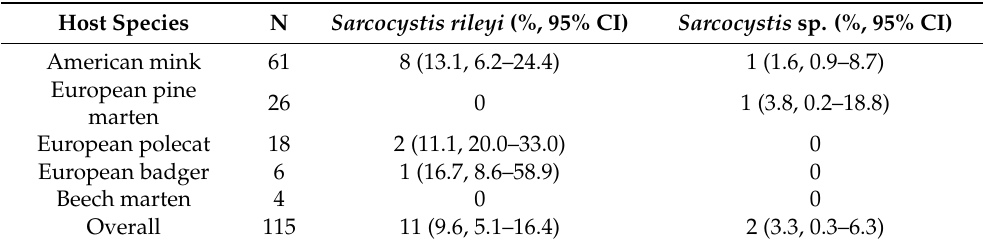
Table 2. Molecular identification of two avian Sarcocystis species in the mucosal scrapings of the examined